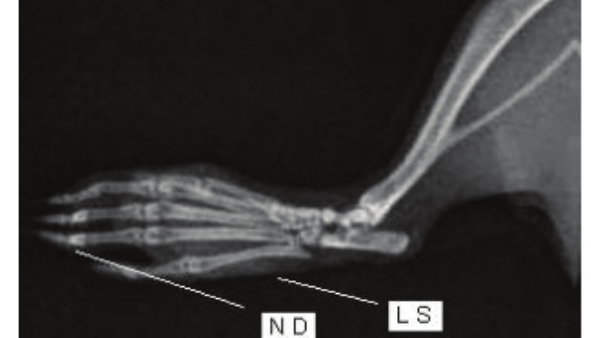
Fig-5: Prophylactic Group 5 Anthraquinone 500mg/kg treated rats shows low swelling (LS) of hind paw and no deformity (ND) of interphalamgeal joints.